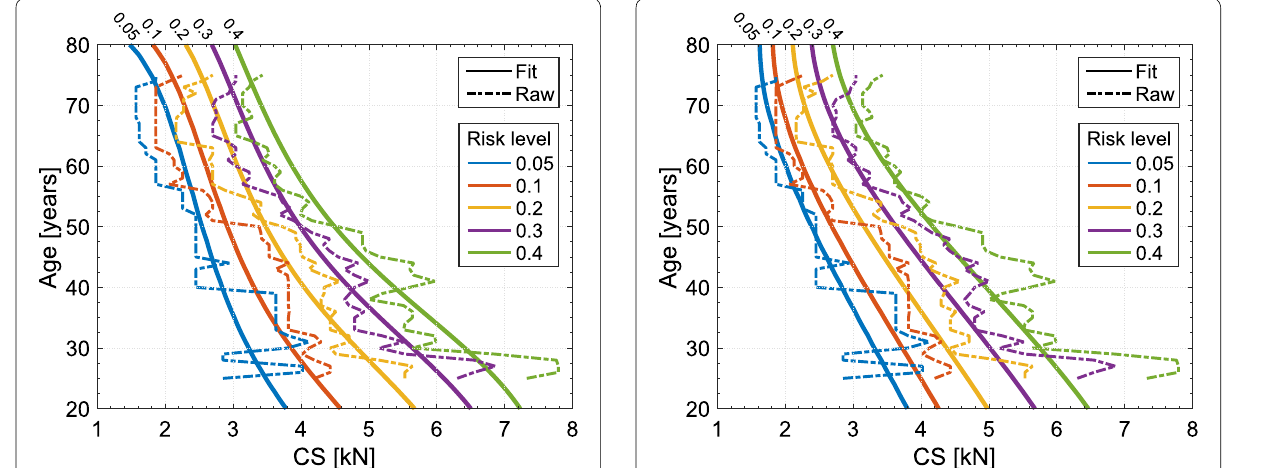
Fig. 8 Contour graph of the risk curves for specific ages. CS, compressive strength